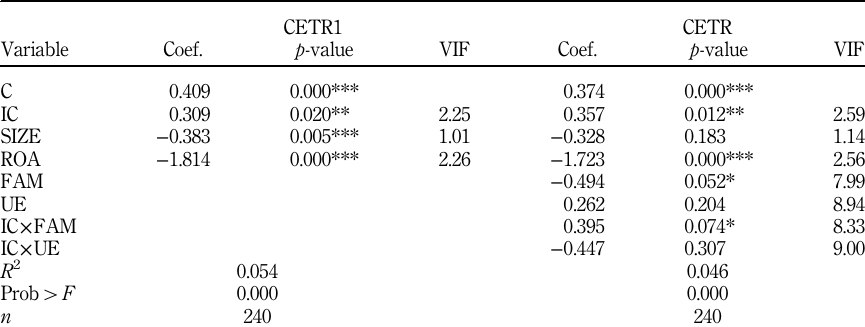
Table IV. Additional testing effects of internal control on tax